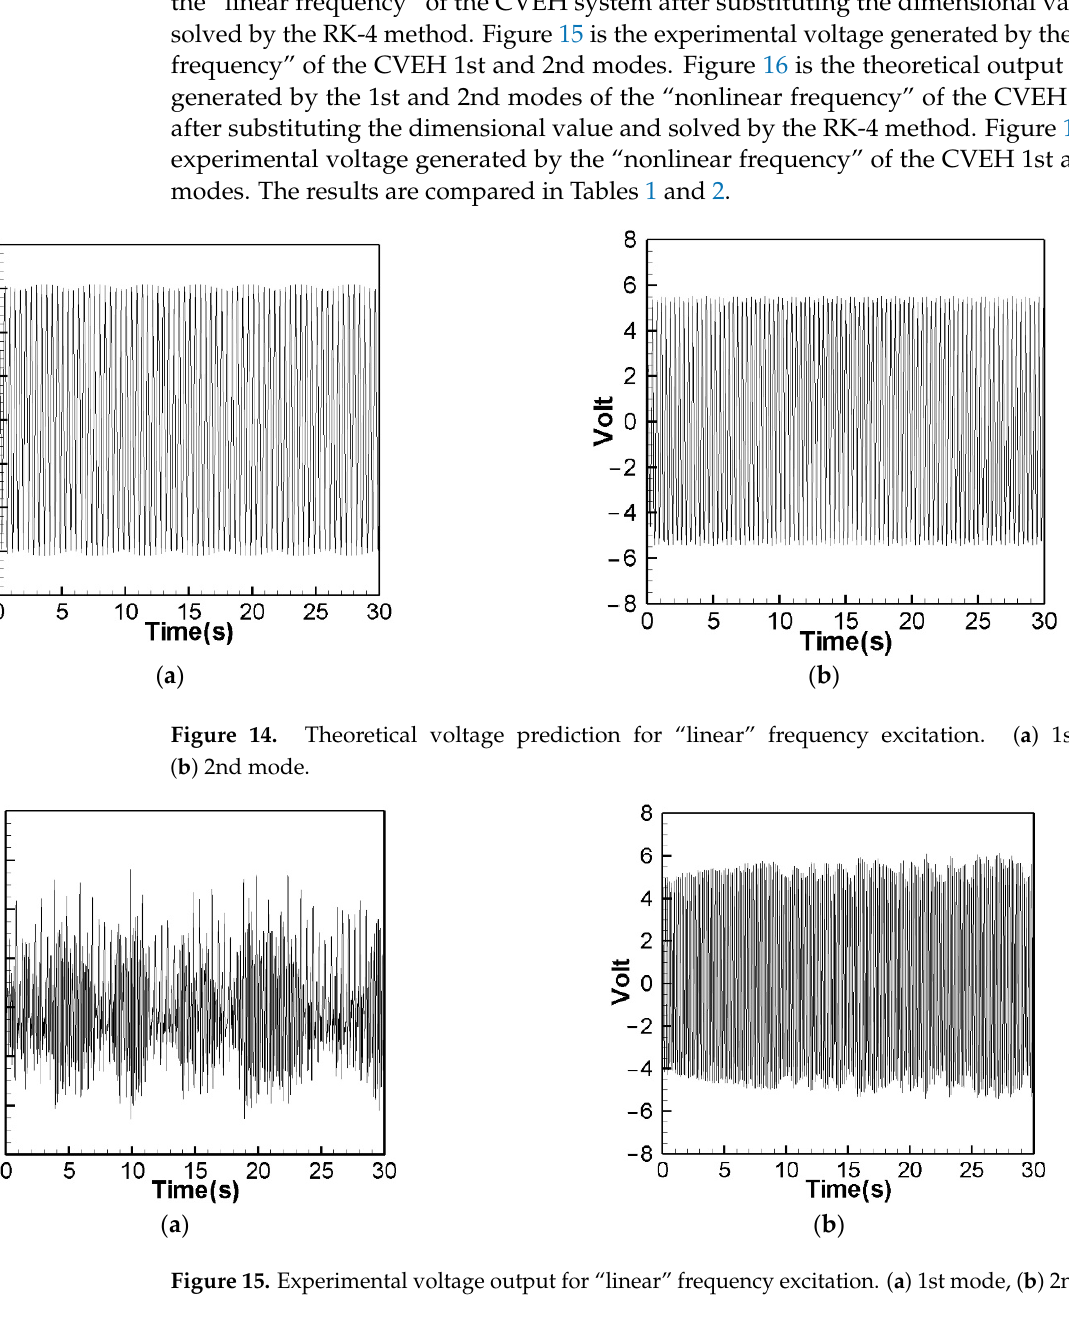
( b ) Figure 16. Theoretical voltage prediction for “nonlinear” frequency excitation. ( a ) 1st mode, ( b ) 2nd mode. ( a ) ( b ) Figure 17. Experimental voltage output for “nonlinear” frequency excitation. ( a ) 1st mode, ( b ) 2nd mode.